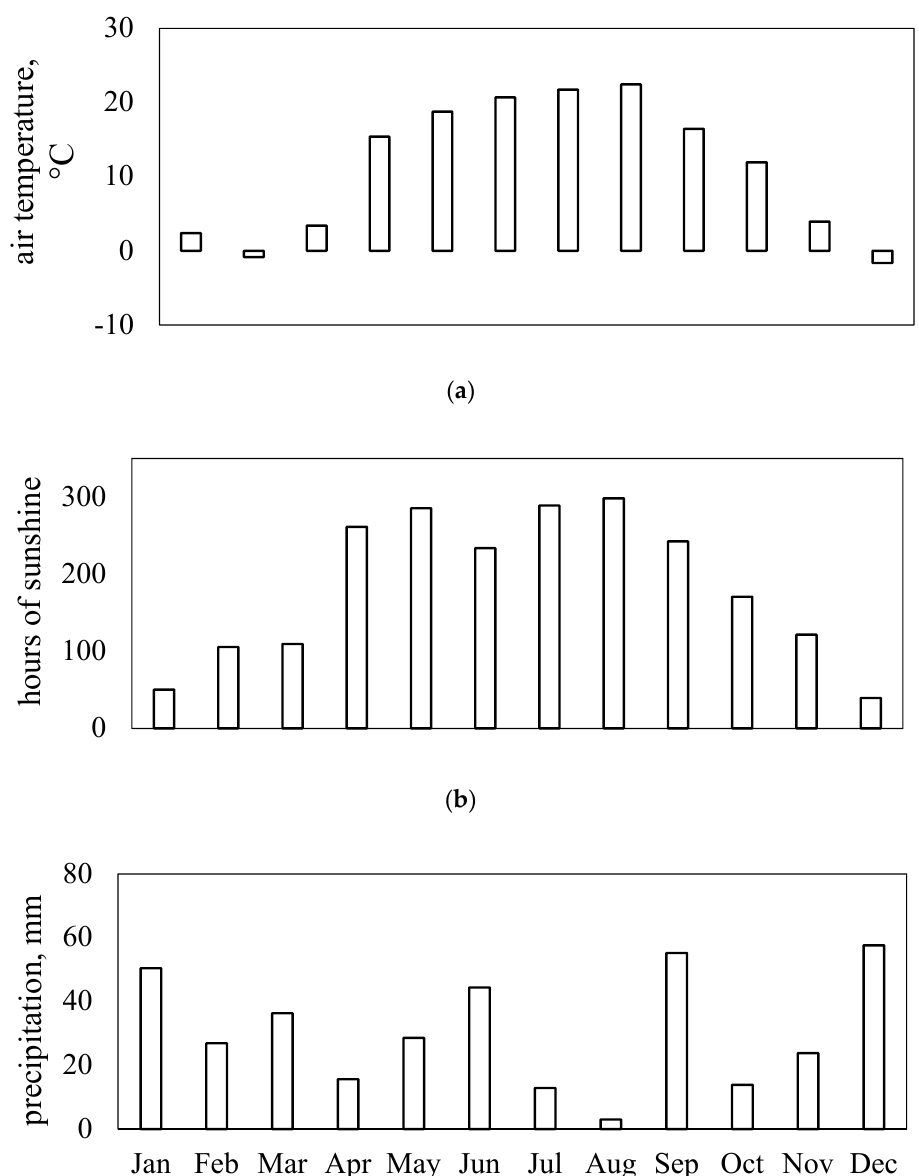
Figure 6. Monthly seasonal variations in the 2018 vegetation season at the Dolná Malanta experimental research field in Nitra in the Slovak Republic; ( a ) air temperature, ( b ) sunshine hours and ( c ) precipitation.